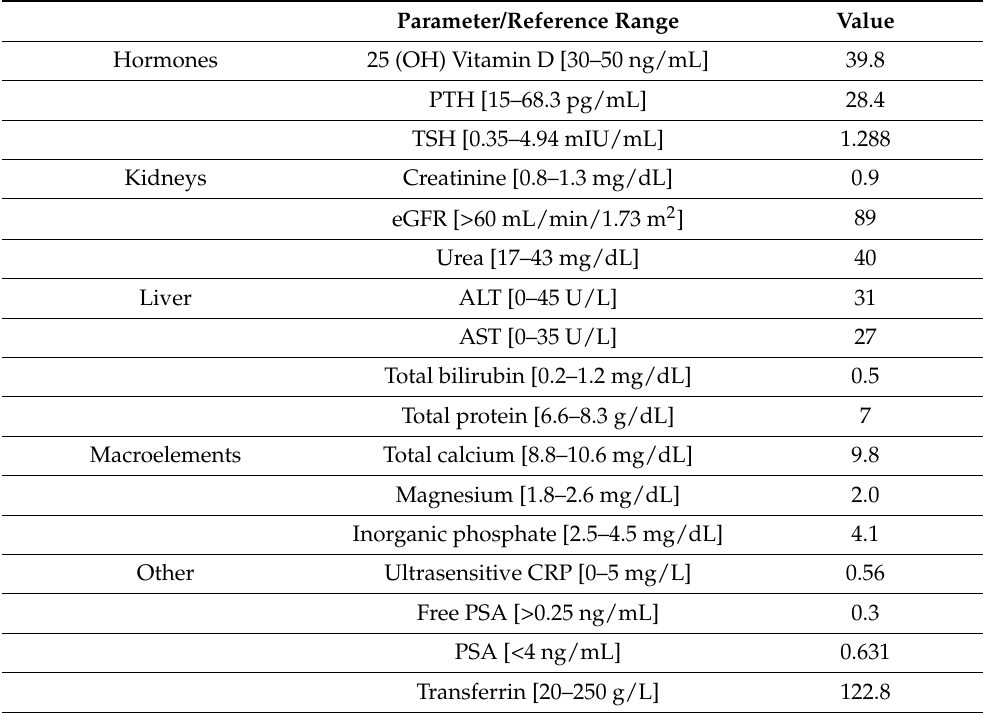
Table 1. Results of selected blood serum